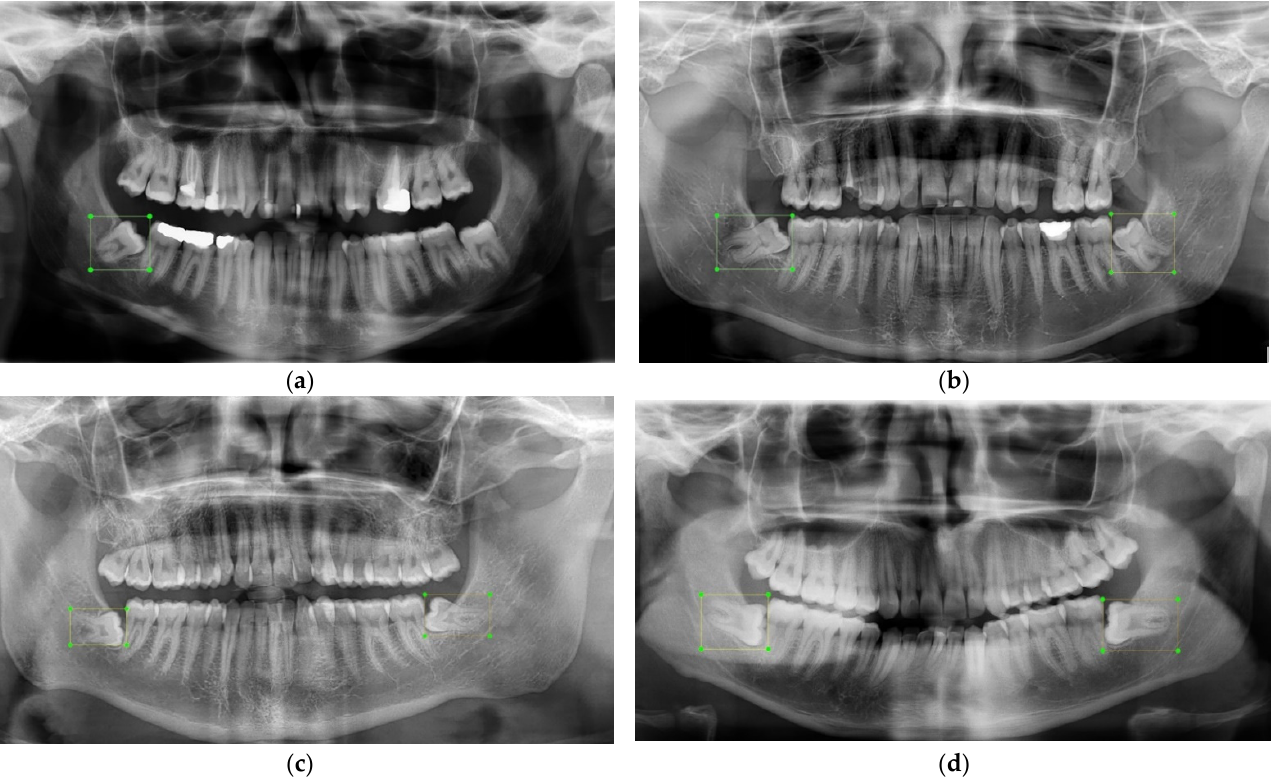
Figure 2. Examples of panoramic radiographs with bounding boxes. ( a ) One impacted tooth—me- sioangular left, ( b ) two impacted teeth—mesioangular left and right, ( c , d ) horizontal left and right.